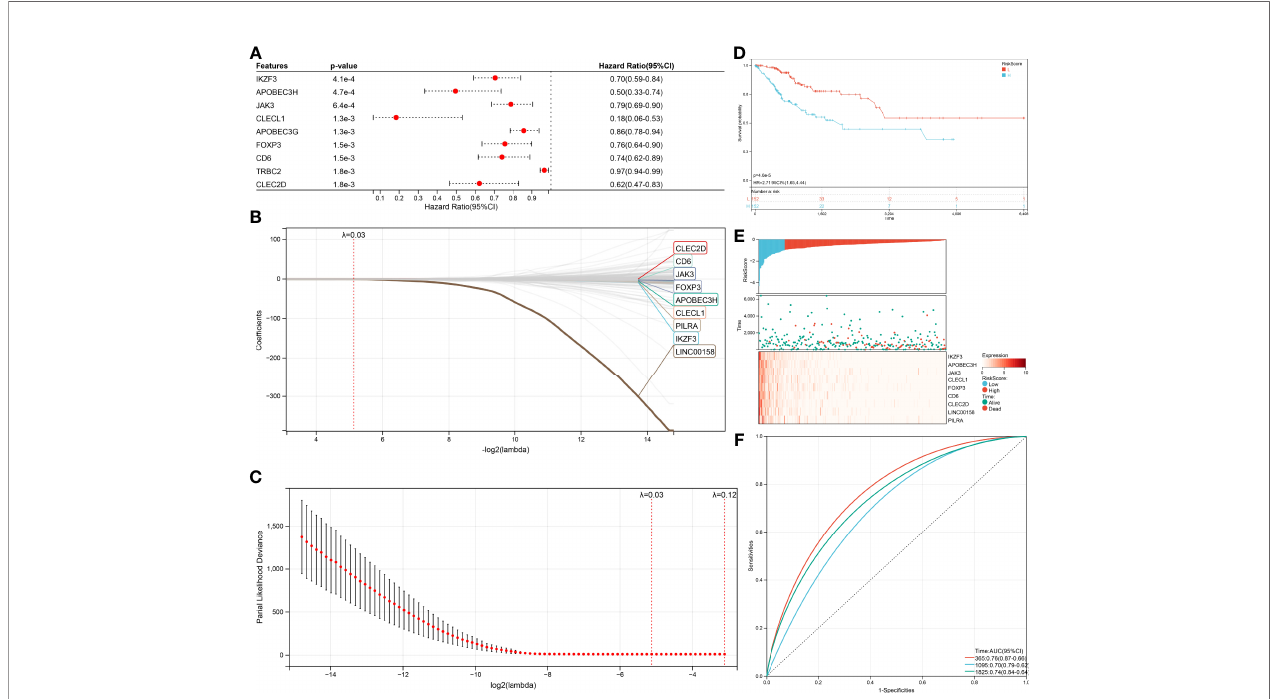
FIGURE 5 | Construction of the Cox and LASSO Cox model. (A) Top nine survival-related genes in Cox model. (B) The trajectory of each independent variable in the survival-related model: the horizontal axis represents the log2 value of the independent variable lambda, and the vertical axis represents the coef fi cient of the independent variable. (C) The con fi dence interval under each lambda in the survival-related model. (D) Top9 relapse-related genes in Cox model. (E) The trajectory of each independent variable in the relapse-related model: the horizontal axis represents the log2 value of the independent variable lambda, and the vertical axis represents the coef fi cient of the independent variable. (F) The con fi dence interval under each lambda in the relapse-related model.